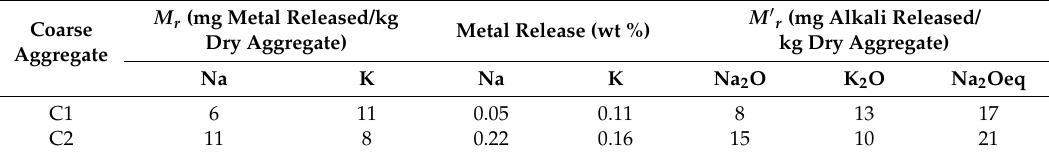
Table 6. Alkali releases from coarse aggregates